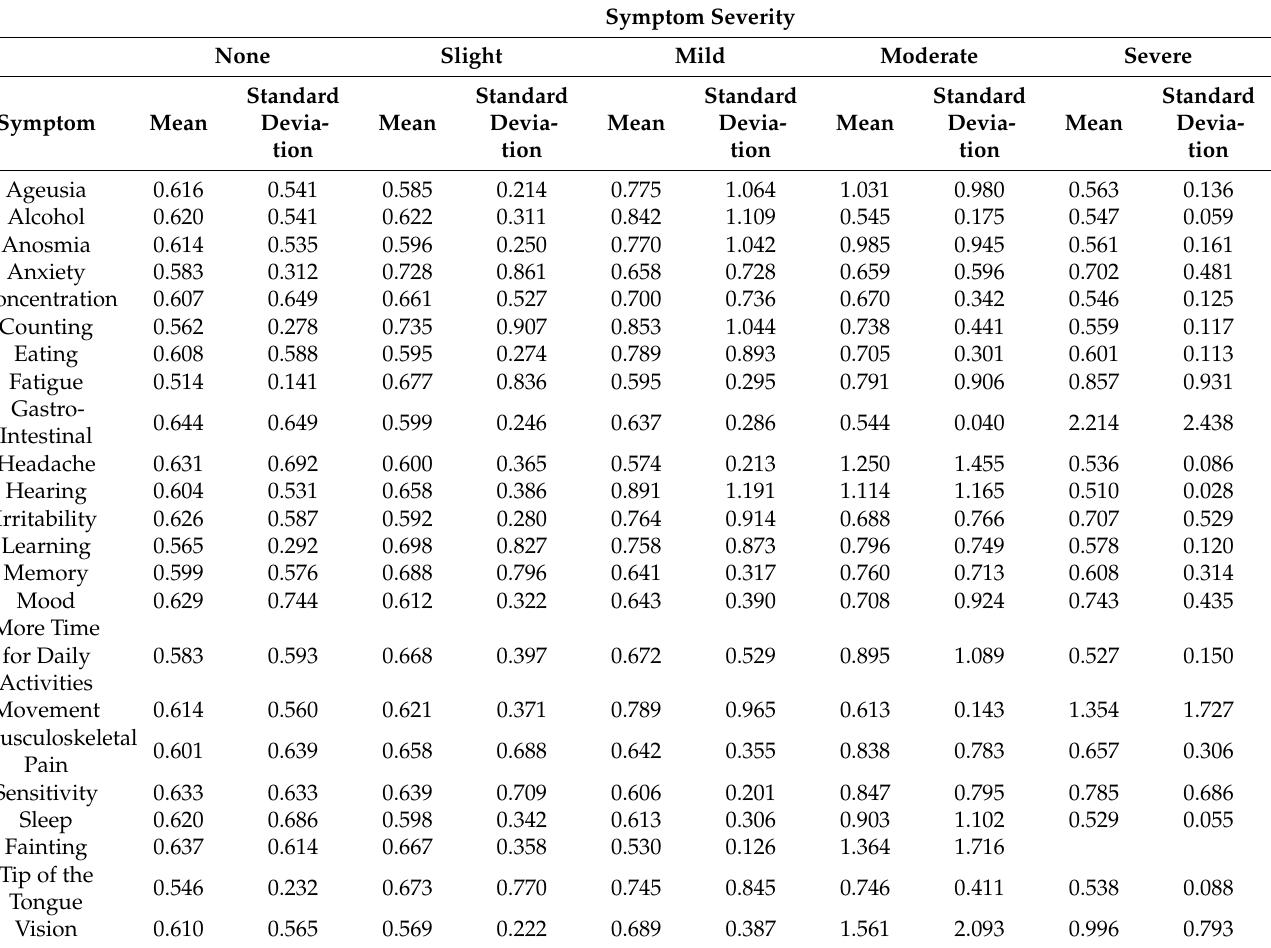
Table 5. Mean Reaction Times calculated within Symptom Severity levels for each symptom